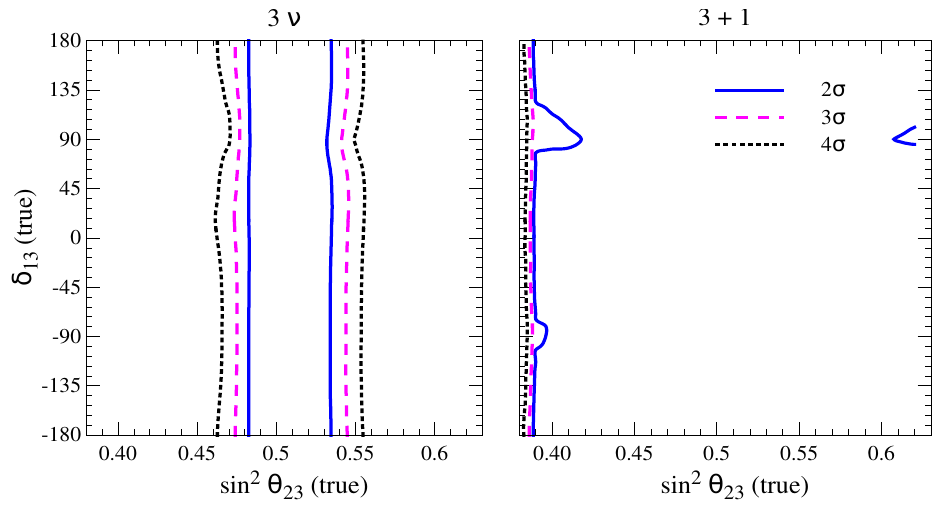
Figure 9 . Discovery potential for identifying the correct octant assuming NH as true choice. The left (right) panel corresponds to the 3 (cid:23) (3+1) case. In the 3 (cid:23) case, we marginalize away ( (cid:18) 23 ; (cid:14) 13 ) (test). In the 3+1 case, in addition, we marginalize away also (cid:14) 14 (true) and (cid:14) 14 (test) (cid:12)xing (cid:18) 14 = (cid:18) 24 = 9 0